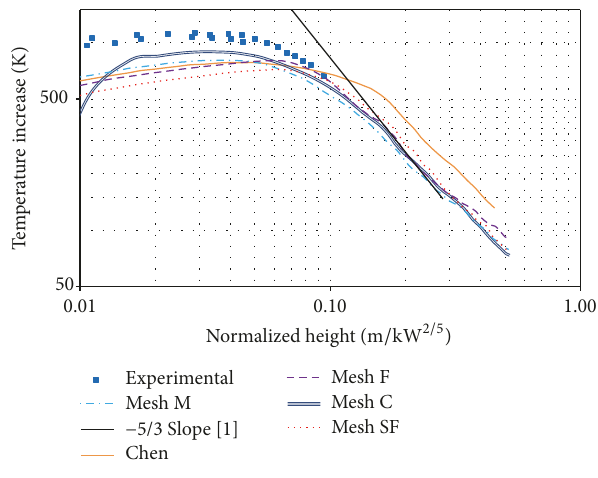
Figure 9: Normalized height ( 𝑧/𝑄 2/5 ) versus temperature increase ( Δ𝑇 ).